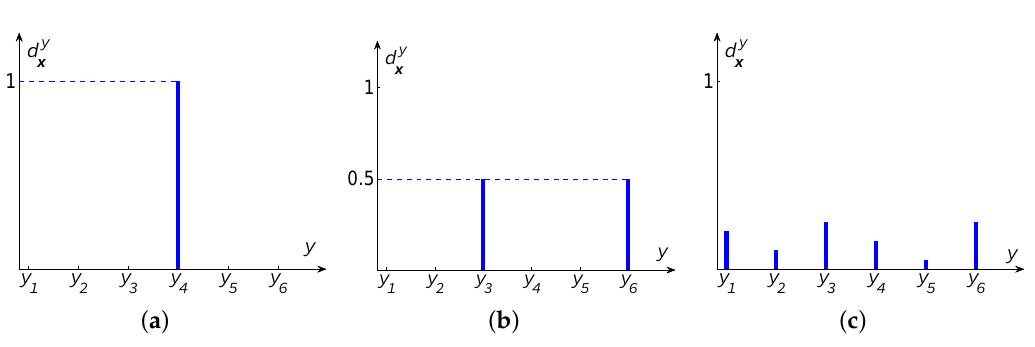
Figure 2. Three different types of label distribution. ( a ) single label; ( b ) multiple label; ( c ) general label